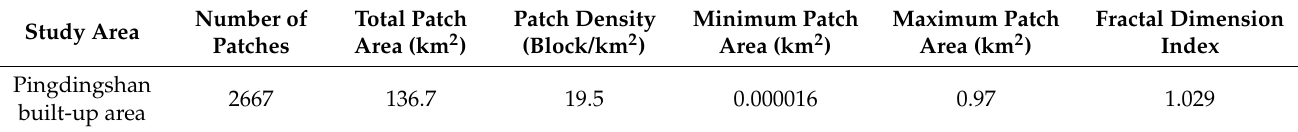
Table 1. Basic parameters of street enclosure patch in built-up area of Pingdingshan